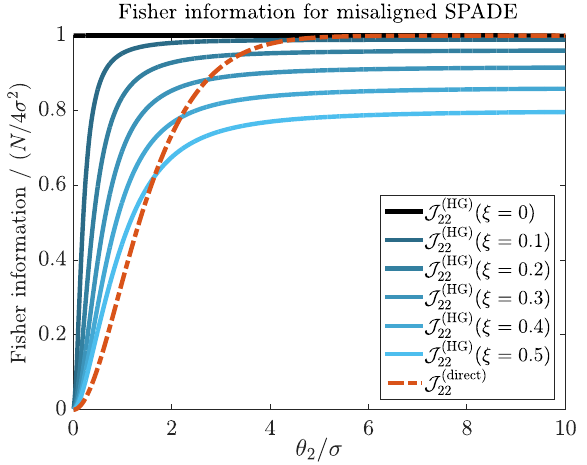
FIG. 11. Fisher information for separation estimation with SPADE with misalignment levels ξ ¼ 0 ; 0 . 1 ; … ; 0 . 5 (solid curves) and direct imaging (dash-dotted curve). The different solid curves can be distinguished by their decreasing values with larger misalignments.